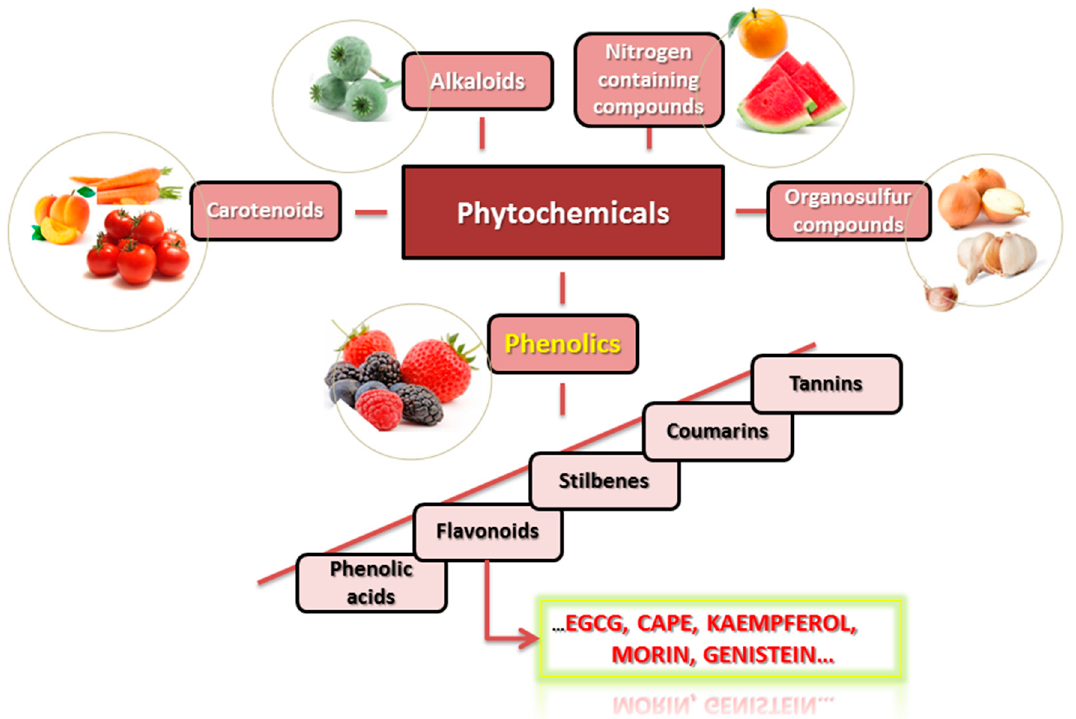
Figure 1. The main classes of phytochemicals and their bioavailability.